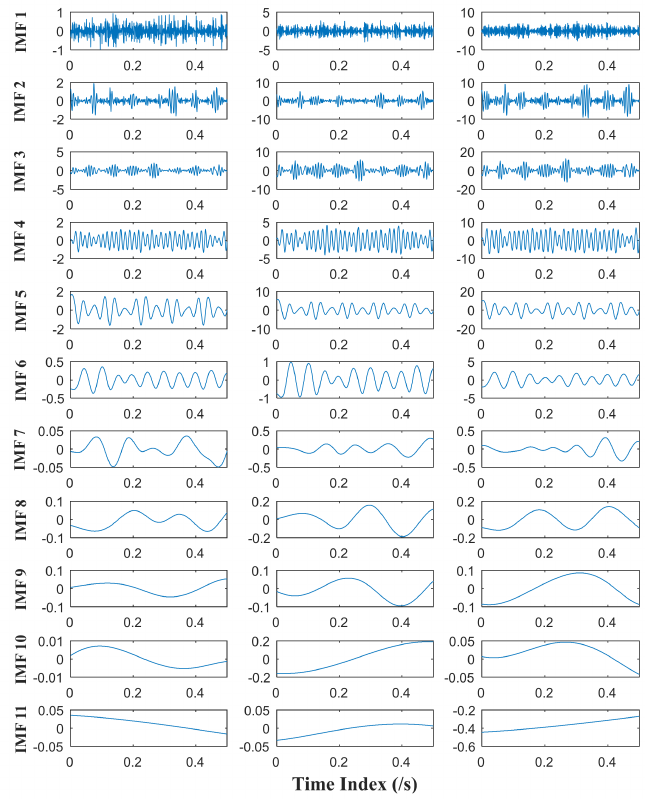
Figure 8. Time domain plots of IMFs of MEMD.